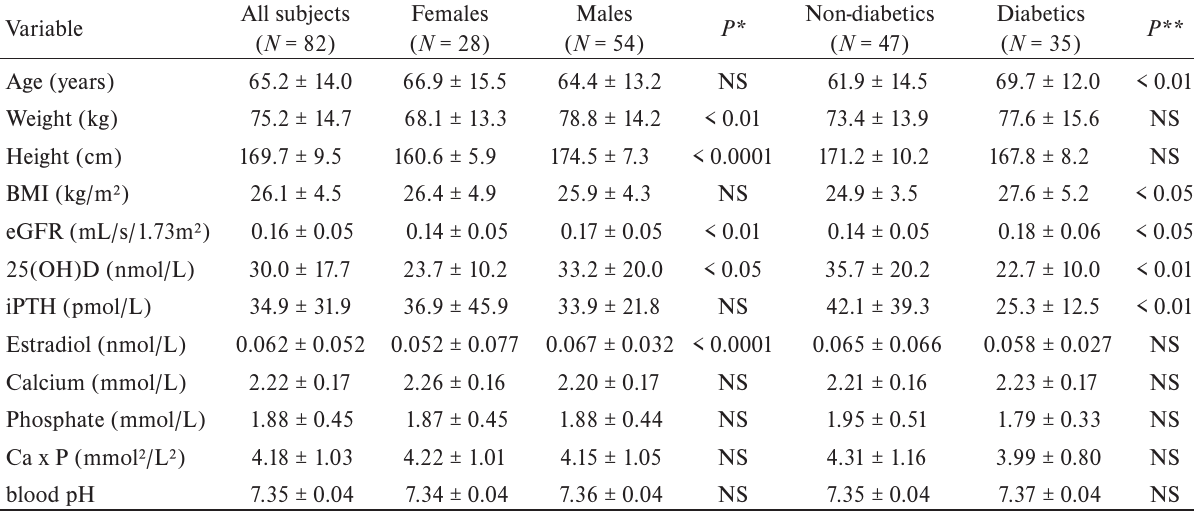
Table 1. Demographic and biochemical data.